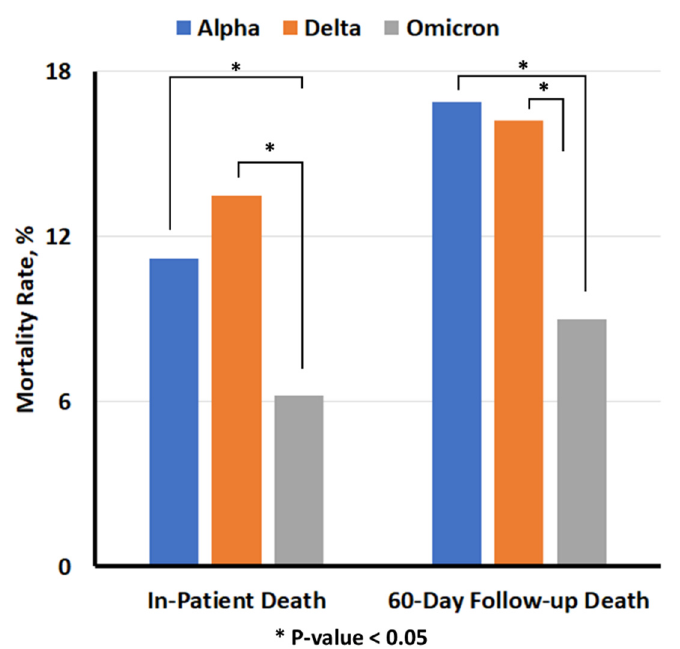
Figure A1. In-hospital mortality among three variation groups: Alpha, Delta, and Omicron after the COVID-19 test.